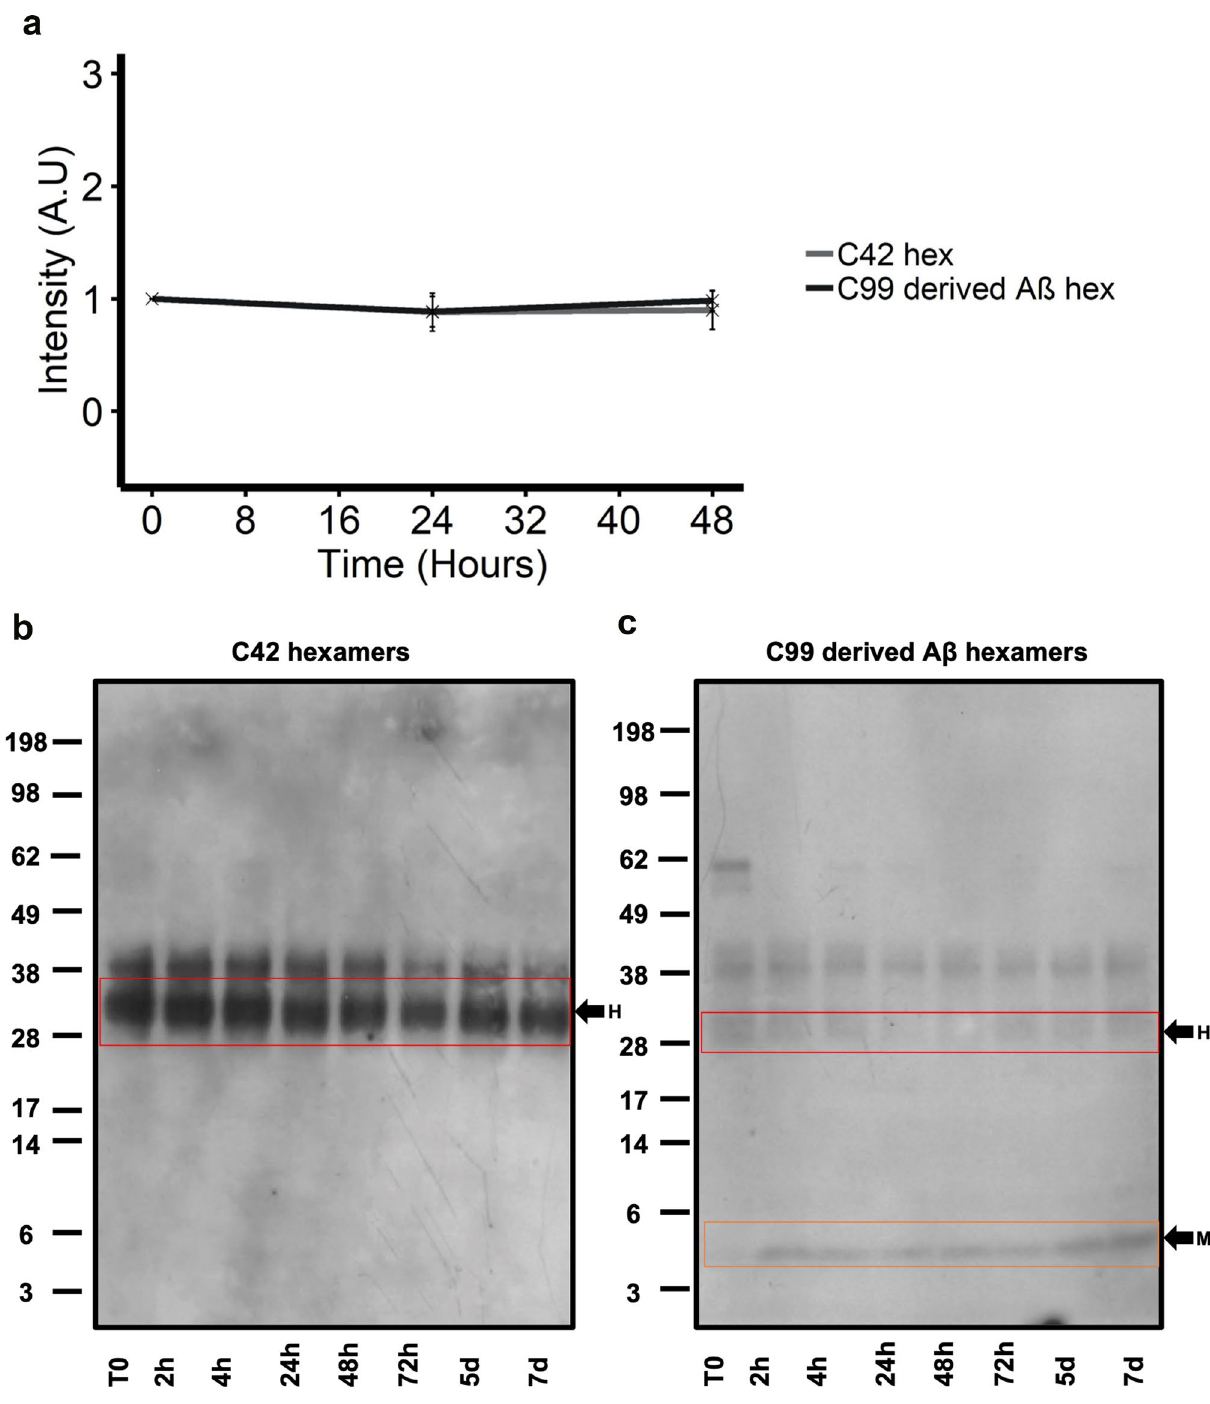
Figure 5. Isolated hexameric Aβ does not self-assemble into higher molecular weight assemblies ( a ) 150 µM isolated hexameric Aβ from C42 and C99 transfected CHO cells was incubated with 20 µM ThT and fluorescence was monitored over 48 h as a measure of fibrillogenesis. No increase in fluorescence was seen for either of the isolated hexamers. ( b and c ) Western blotting and detection with the W0-2-antibody revealed both hexamers (red box) do not assemble into higher molecular weight assemblies over 7 days. Hexamers from C99 transfected CHO cells, do, however disassemble into monomers (orange box) over time as was detected from 2 h